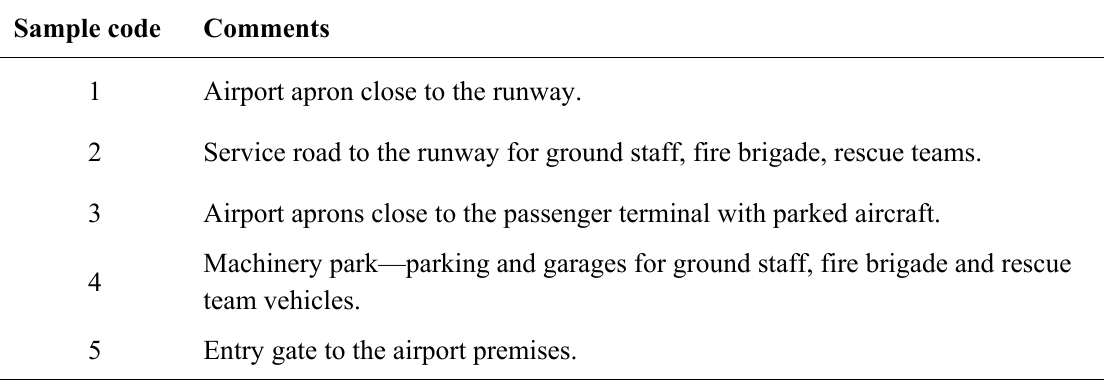
Table 1. Sampling site description of the Lech Wa ł esa Airport at Gda ń sk R ę